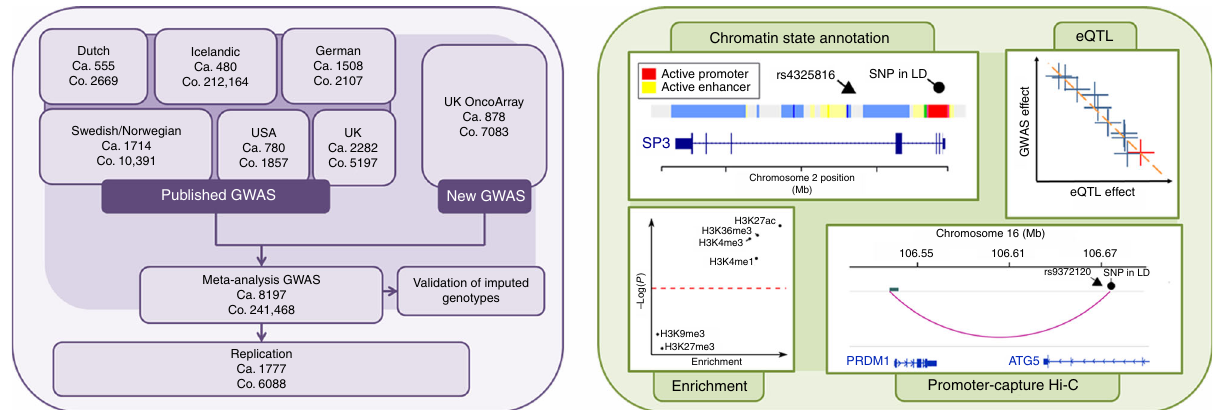
Fig. 1 GWAS study design. Details of the new and existing GWAS samples, including recruitment centres or trials and quality control, are provided in Supplementary Tables 1 and 2. Trials or centres from which replication samples were recruited are detailed in Supplementary Table 3. Ca.: cases, Co.: controls, eQTL: expression quantitative trait loci, SNP: single-nucleotide polymorphism, LD: linkage